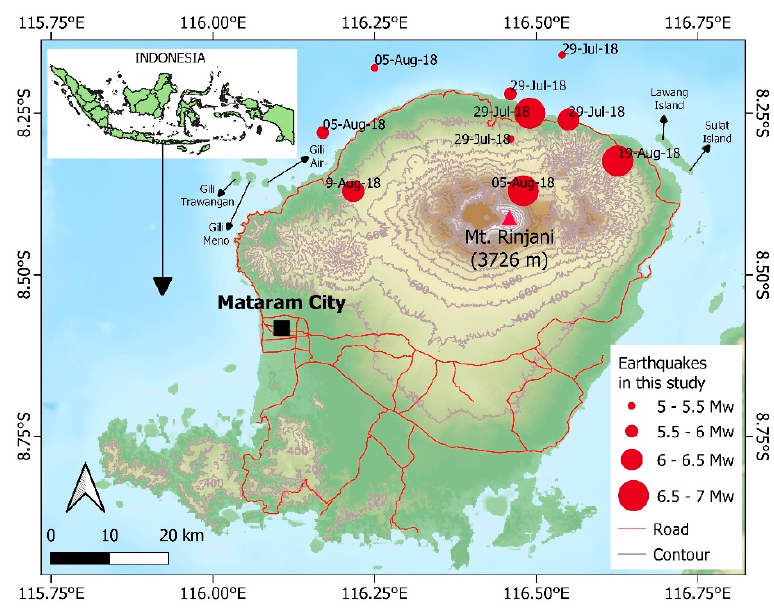
Figure 1. Epicentres of major earthquakes in Lombok